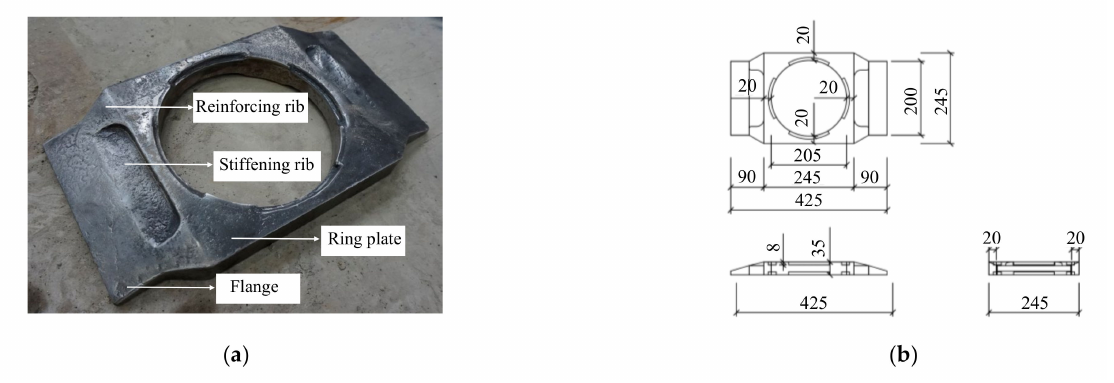
Figure 3. CSS for circular-tube-column frame (unit: mm): ( a ) Three-dimensional diagram; ( b ) Three or- thographic